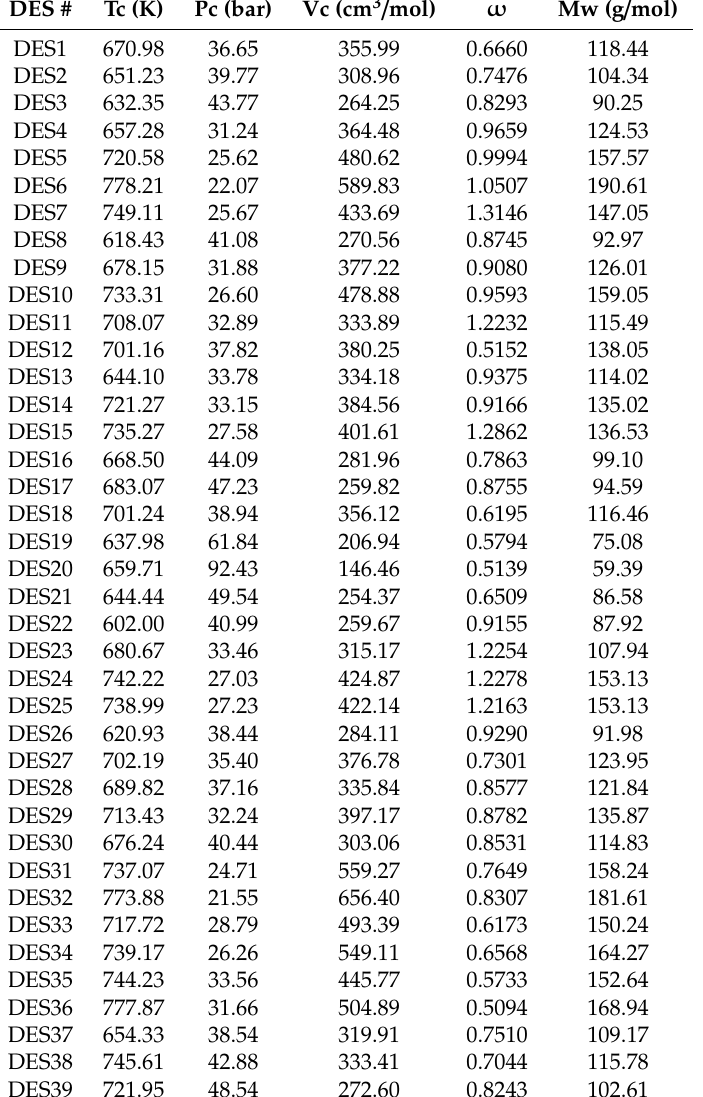
Table 2. Calculated values of critical properties and acentric factors for all of the investigated DESs in this study